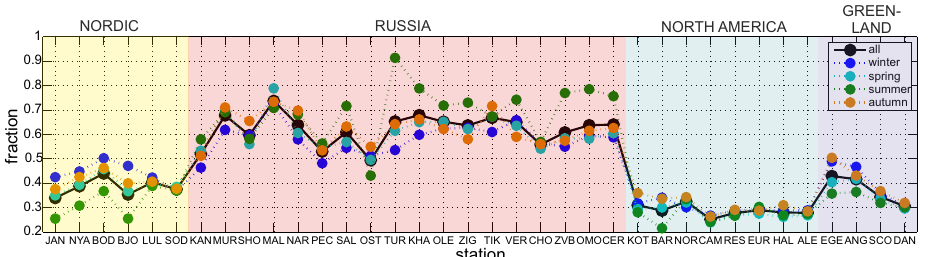
Fig. 8. Fraction of humidity inversions which occurred simultaneously with a temperature inversion at least partly within the humidity inversion layer.